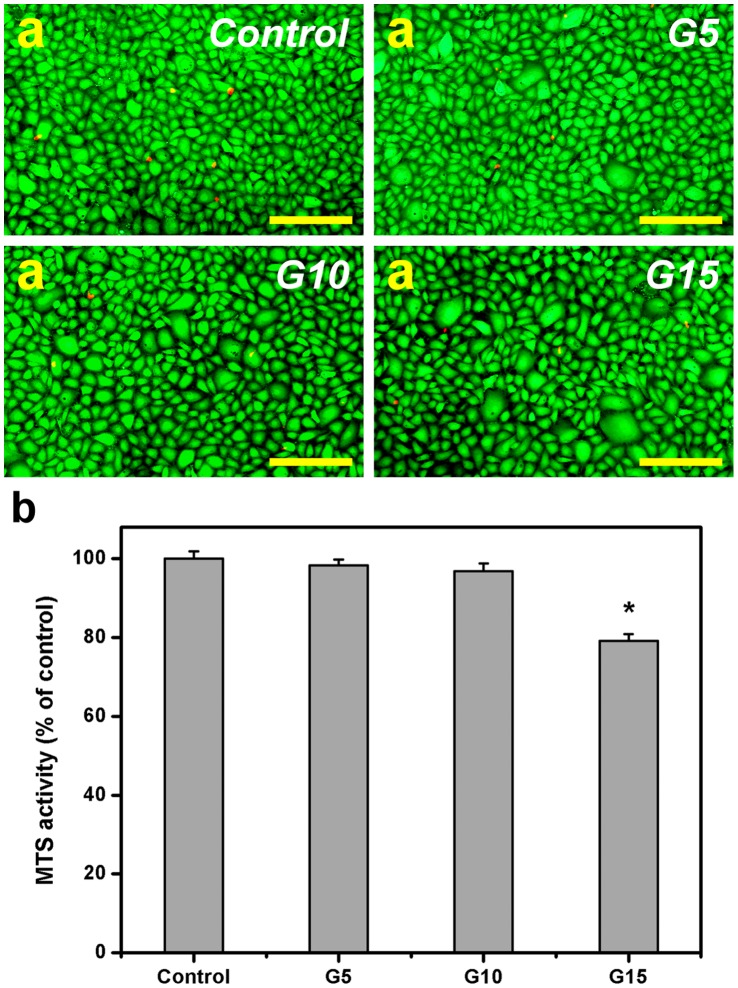
Cell viability and proliferation assays.(a) Cell viability of rabbit corneal endothelial cell cultures was determined by staining with Live/Dead Viability/Cytotoxicity Kit in which the live cells fluoresce green and dead cells fluoresce red. Fluorescence images of cells in controls (without gelatin materials) after 12 h of direct contact with different types of gelatin samples. Scale bars: 100 µm. (b) Cell proliferation assay of rabbit corneal endothelial cell cultures after 12 h of direct contact with various gelatin samples. Results are expressed as percentage of control groups (MTS activity of cells cultured in the absence of gelatin materials). An asterisk indicates statistically significant differences (*P<0.05; n = 5) as compared with the control groups.